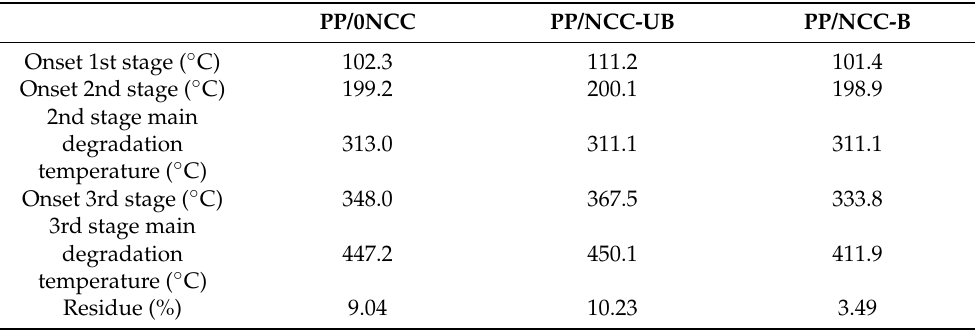
Table 5. The thermal properties for kenaf core nanocomposites reinforced bleached and un- bleached